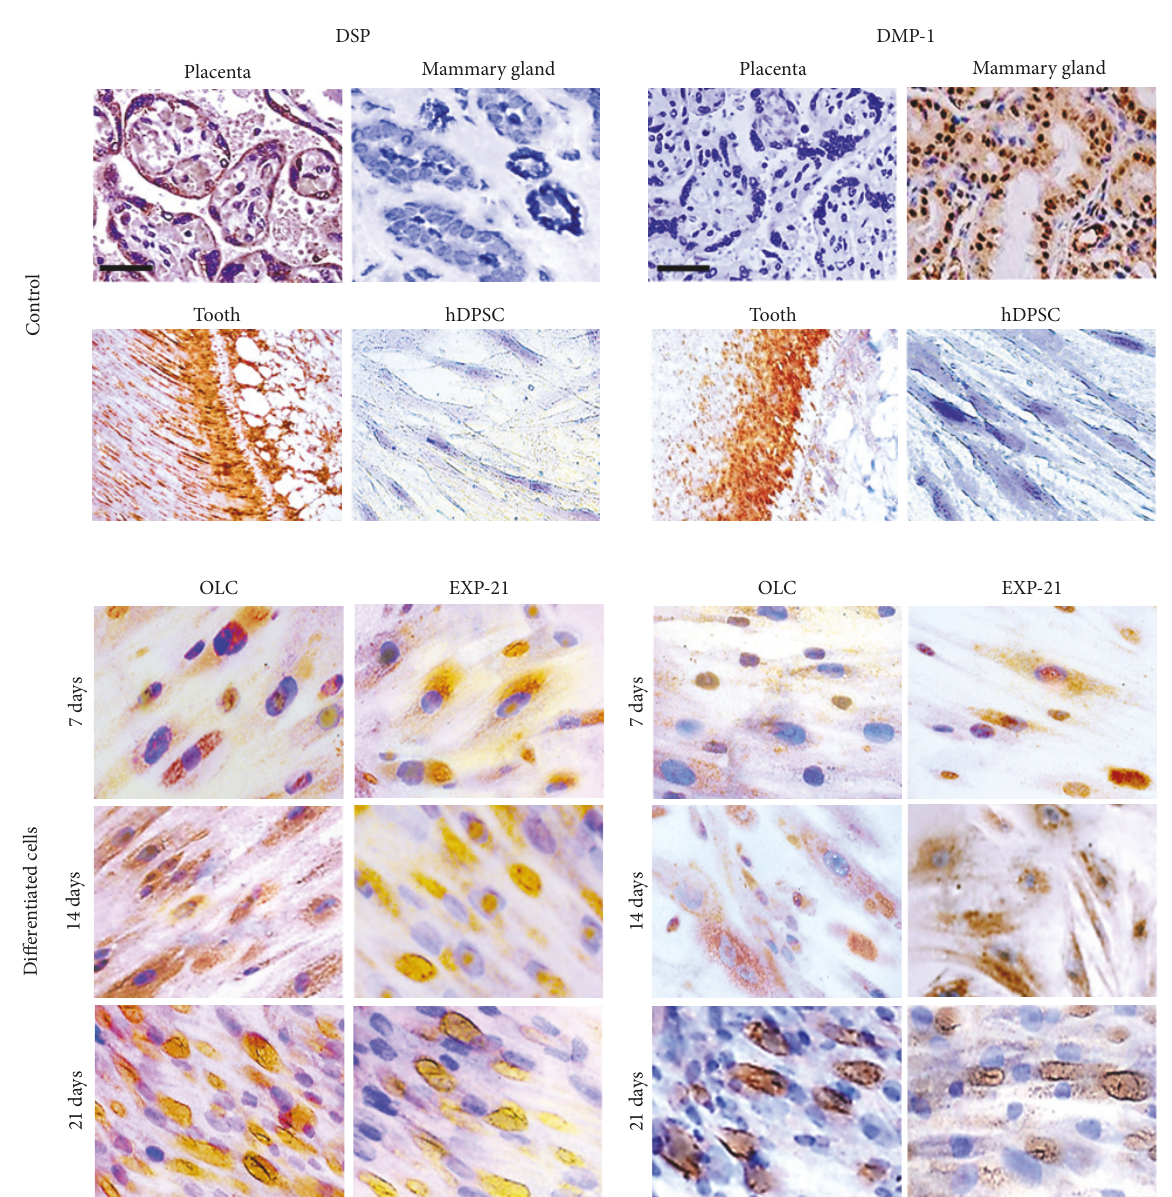
Figure 2: Immunocytochemical detection of DSP and DMP-1 odontogenic markers . Upper panel: the staining pattern in positive controls for DSP (placenta), DMP-1 (mammary gland), and dental pulp tissue positive for both markers. Mesenchymal cells are negative for these markers. Lower panel: DSP and DMP-1 staining pattern in OLC differentiating cultures for 7, 14, and 21 days and reseeded expanded cells (EXP-21) at 7, 14, and 21 days after differentiation. Note the cytoplasmic, nuclear, and late extracellular DSP staining pattern (OLC-21 and EXP-21, left panel). DMP-1 is expressed in both nuclei and cytoplasm and also in extracellular space as matrix vesicles (OLC-21 and EXP-21, right panel). Bar correspond to 100 𝜇